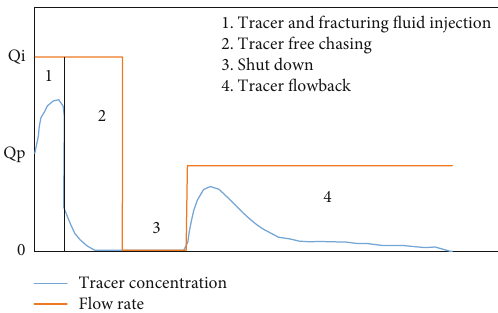
Figure 1: Schematic of the general process for performing tracer fl owback in a multistage hydraulically fractured well modi fi ed after